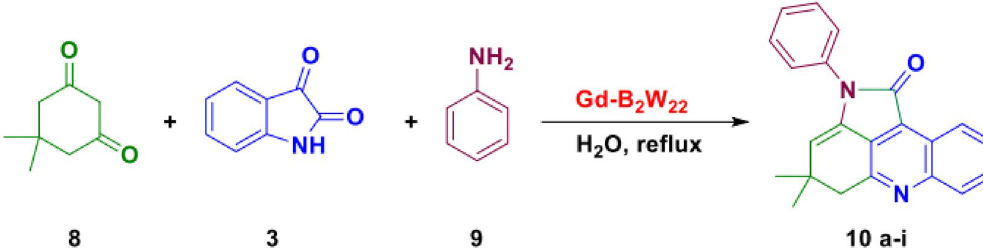
Figure 5. Synthesis of pyrroloacridine derivatives.